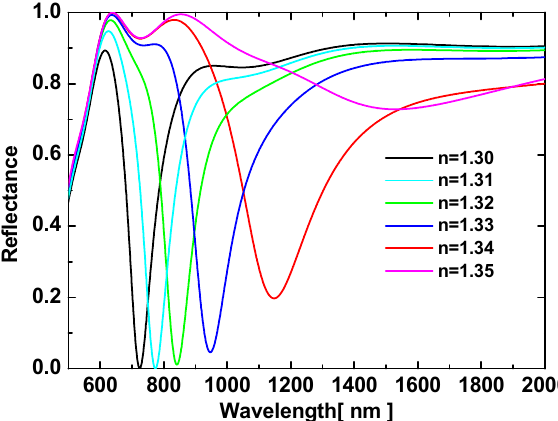
Figure 7. Reflection spectra for an SPR structure with an infinite analyte thickness.